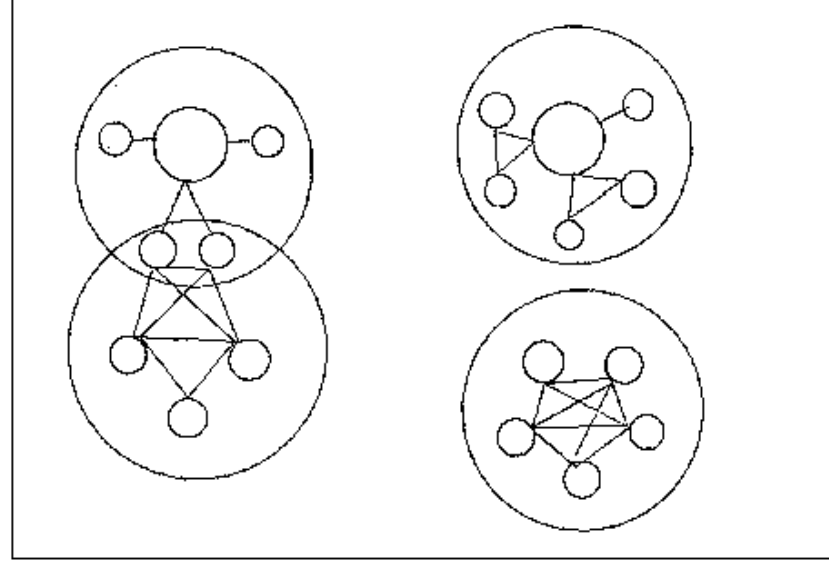
FIGURE 4: COEXISTENCE OF HECEMONIC ANO RECIONAL